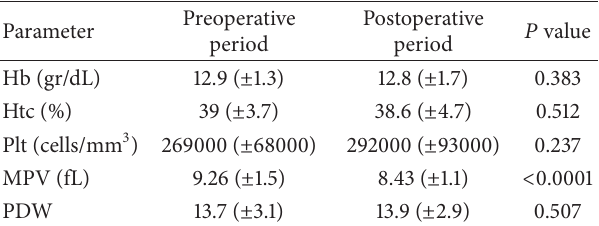
Table 1: Laboratory parameters of the patients (mean ± standard